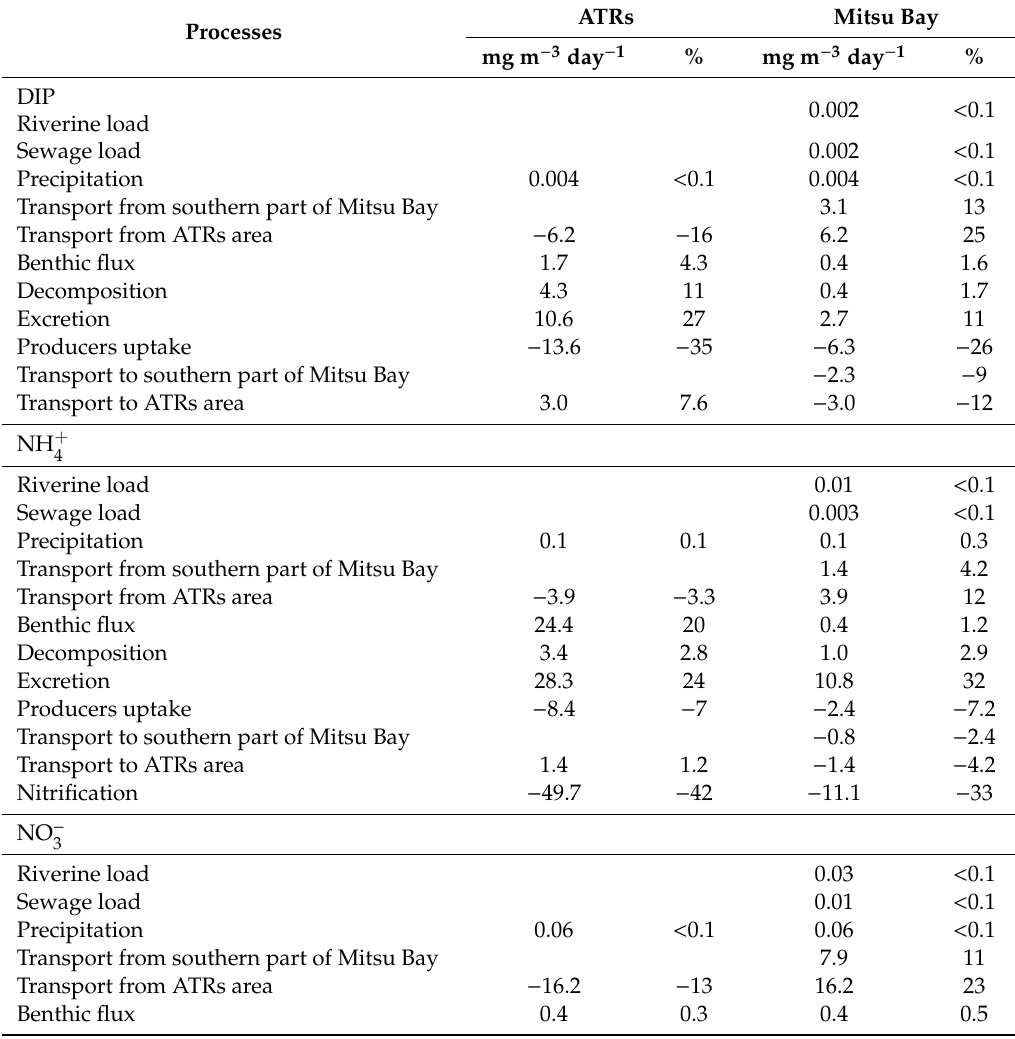
Table 2. Inflow and outflow rates of various processes (mg m − 3 day − 1 ) and their contributions (%) to nutrient stocks. Minus sign ( − ) indicates nutrient outflow from the standing